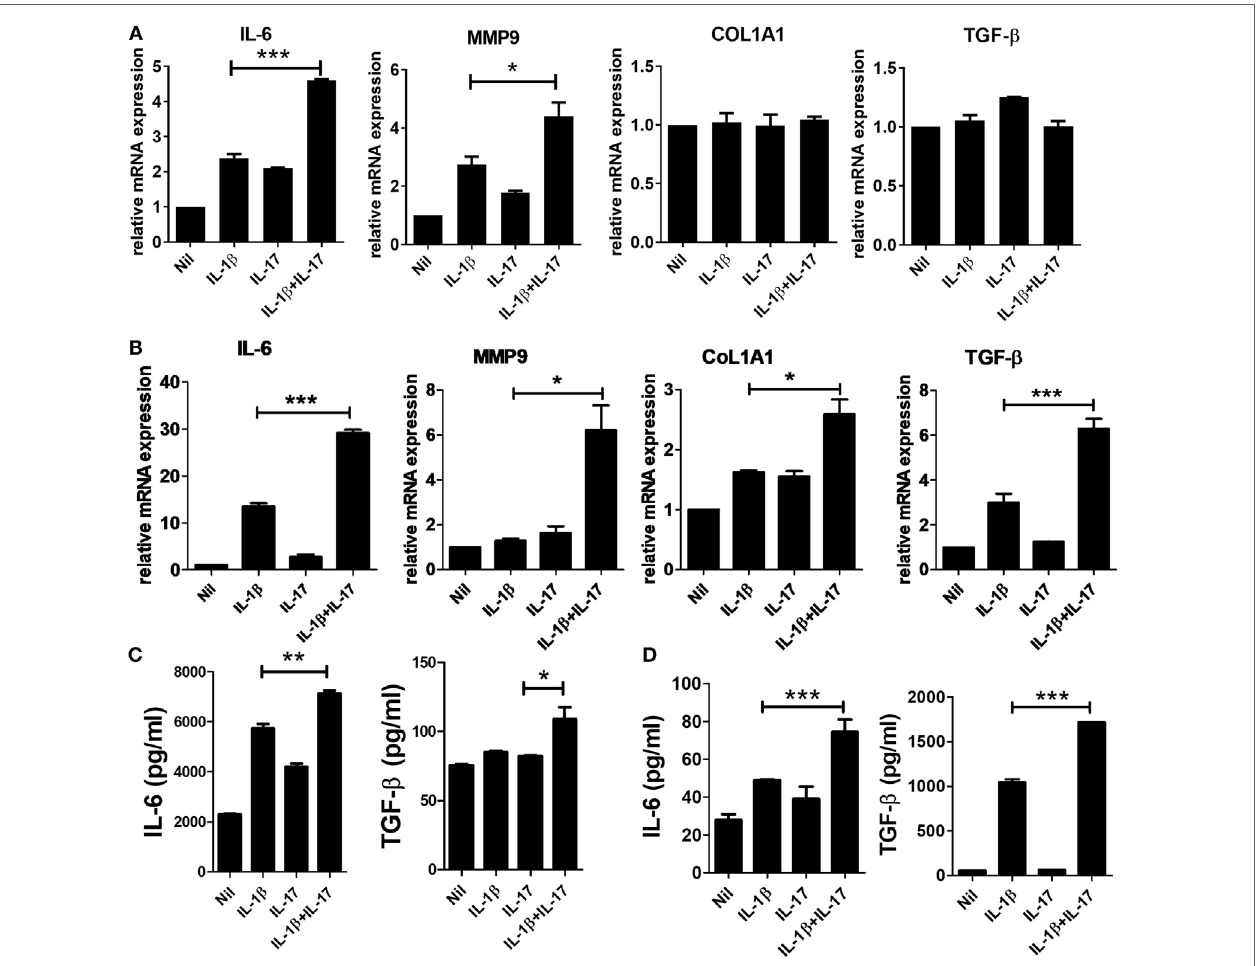
FigUre 1 | Increased inflammatory and profibrotic cytokine expression induced by IL-1 and IL-17 in dermal fibroblasts. (a,B) The expression of messenger RNA for the indicated genes in IL-1- and/or IL-17-treated murine (a) and human (B) dermal fibroblasts was measured by real-time quantitative polymerase chain reaction analysis. (c,D) IL-6 and TGF- β concentrations in culture supernatants of IL-1- and/or IL-17-treated murine (c) and human (D) dermal fibroblasts were measured by enzyme-linked immunosorbent assay. The data are expressed as the mean ± SEM for three independent experiments per group. * p < 0.05, ** p < 0.01, *** p <